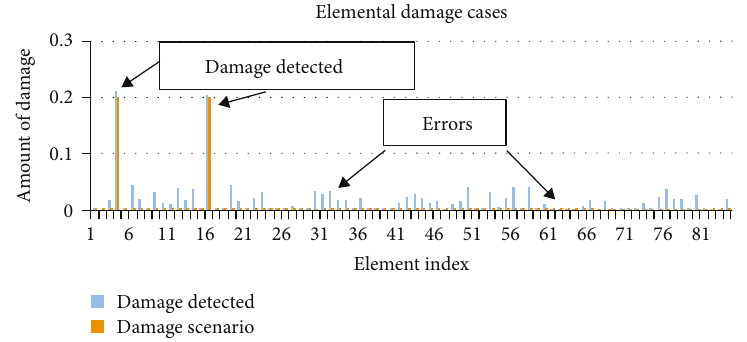
Figure 13: Damage locations in damage scenario